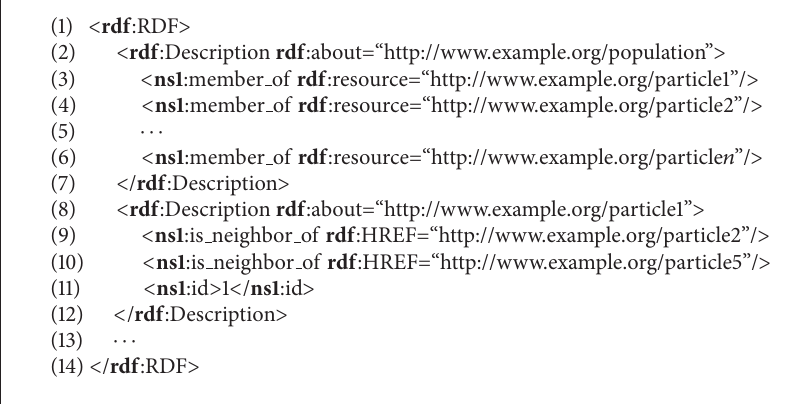
Algorithm 5: Pseudocode of the PSO population in RDF.